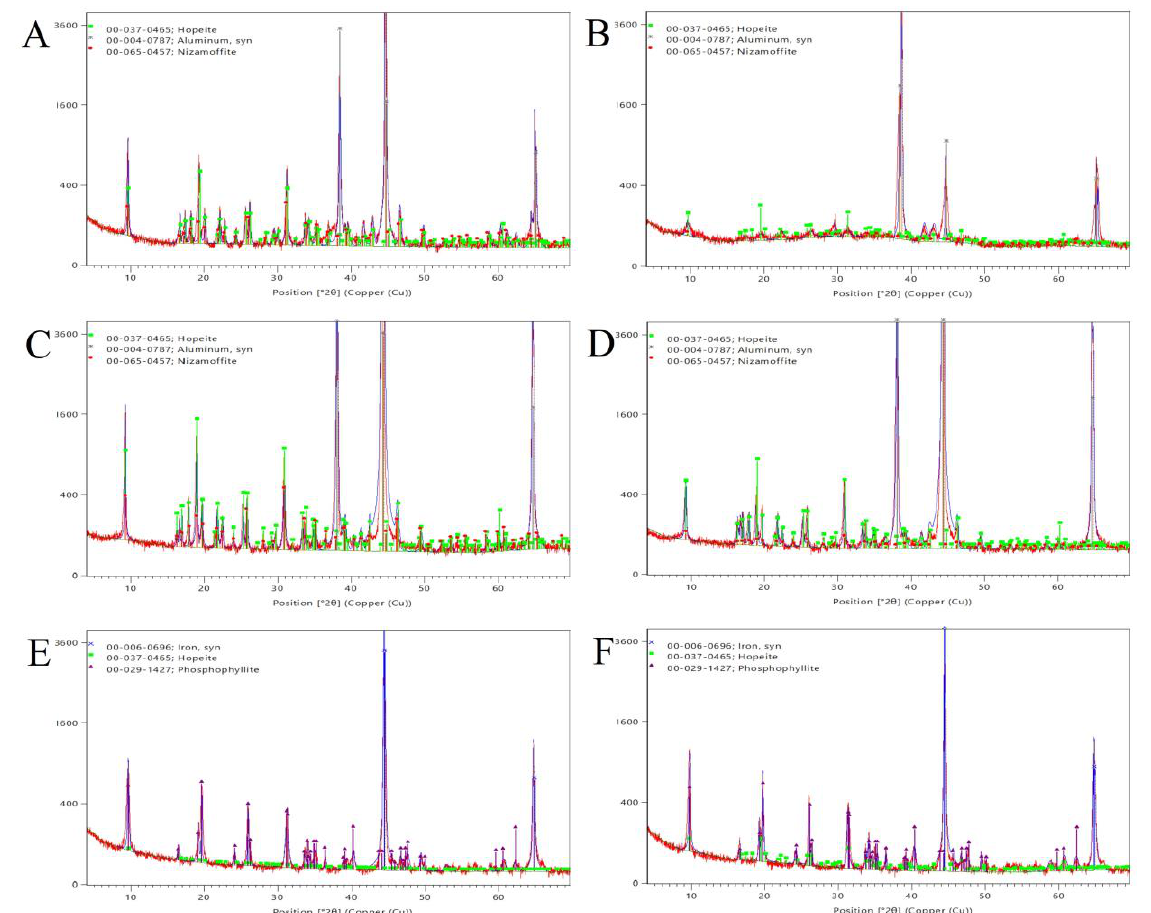
Figure 8. The XRD patterns of phosphate coatings: AL1-N ( A ), AL1-NG ( B ), AL2-N ( C ), AL2-NG ( D ), ST-N ( E ), ST-NG ( F ).